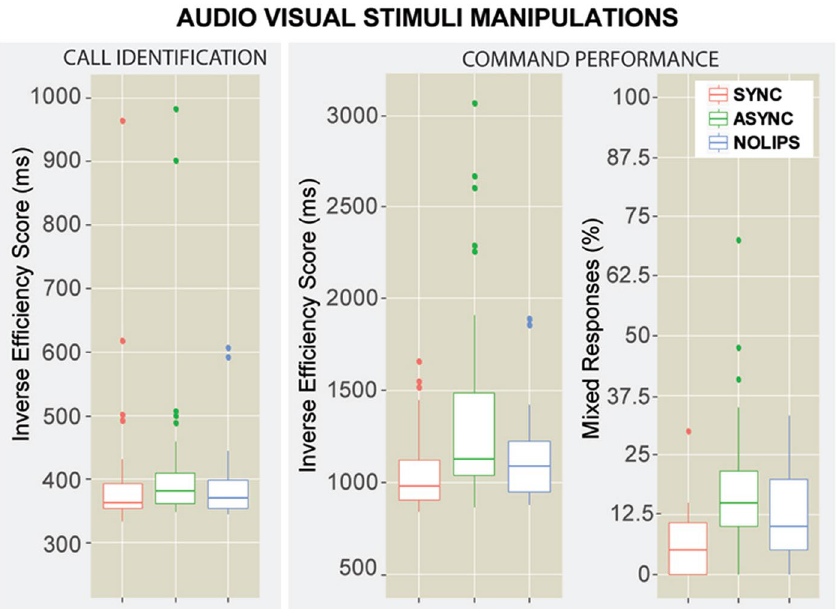
Figure 1. Audio Visual Stimuli (AVS) Manipulations results. Box-plots representing the Inverse Efficiency Score (IES) for the AVS conditions: SYNC , ASYNC 1, NOLIPS . On the left the CALL identification IES, on the right the COMMAND performance and % of mixed